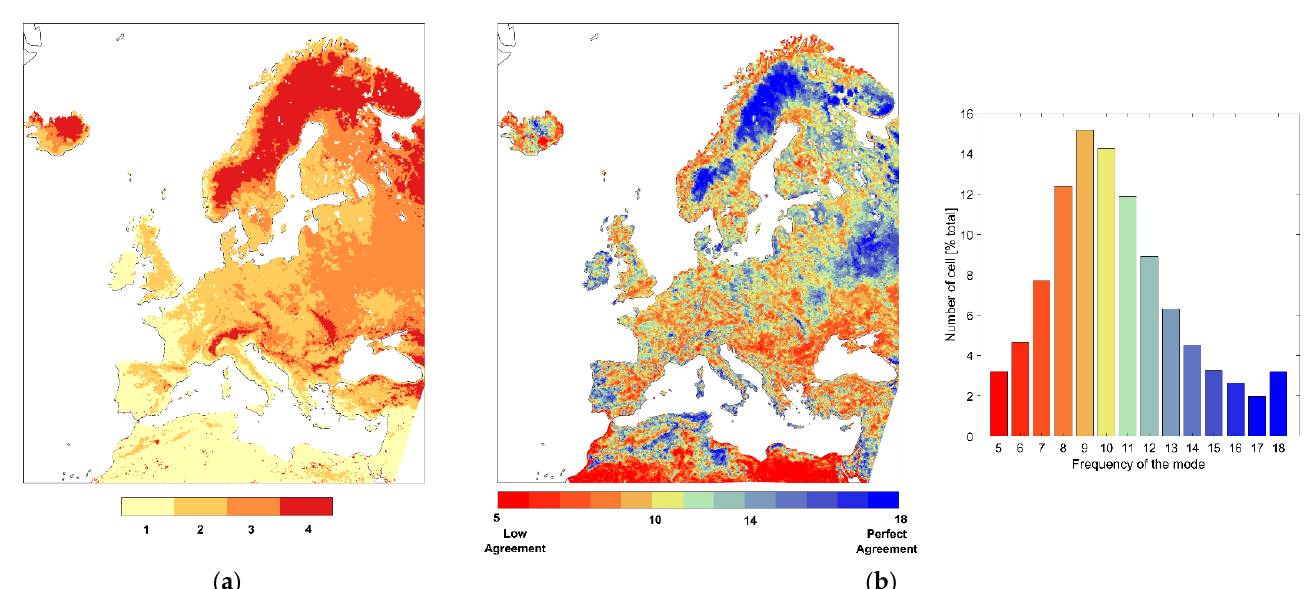
Figure 6. Mode of quartile ( a ) and frequency of the mode map and histogram ( b ) among the 18 different projections of expected changes in characteristic ground snow loads in the time window 2011–2050 with respect to 1951–1990. In ( b ) red areas in the map indicate lower intermodel agreement and higher uncertainty while blue areas indicate higher agreement and lower uncertainty. The histogram is drawn for the frequency of the mode considering the number of cells as % of the total in the EUR-11 domain.